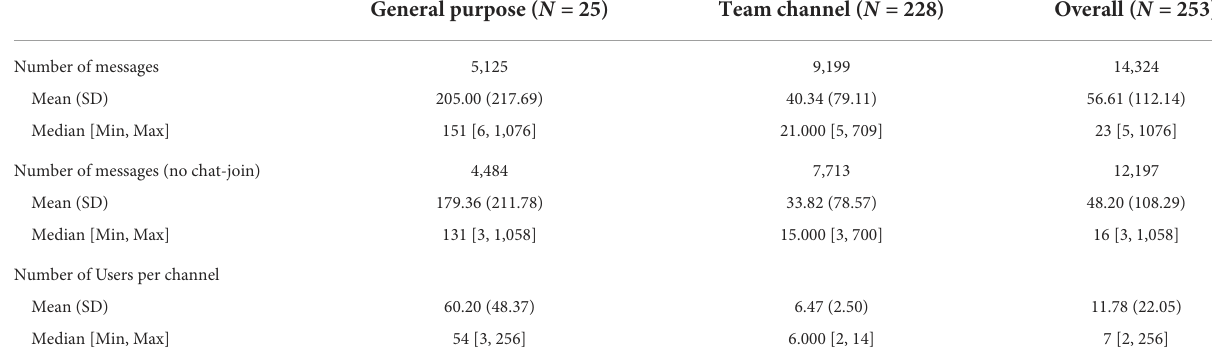
TABLE 2 Data-set descriptors-channel data.